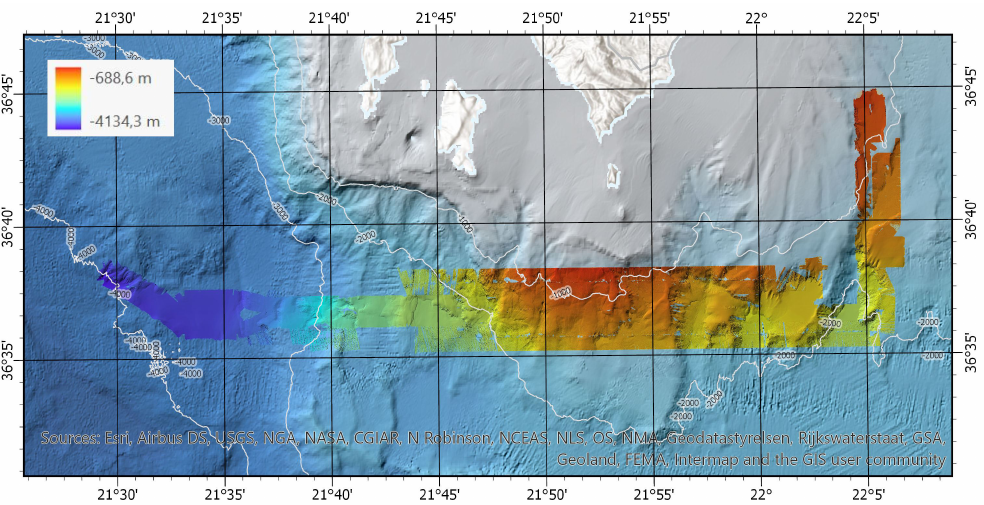
Figure 8. The results of survey: bathymetry, combined from all sensors, presented as 5-m GRID, depicted in the form of shaded relief. EMODnet bathymetry as a background.